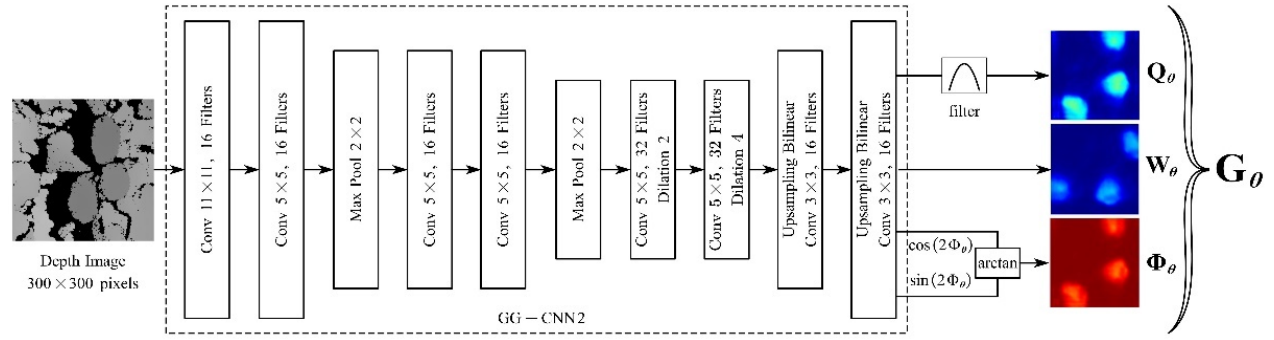
Figure 6. Network architecture for GG-CNN2.